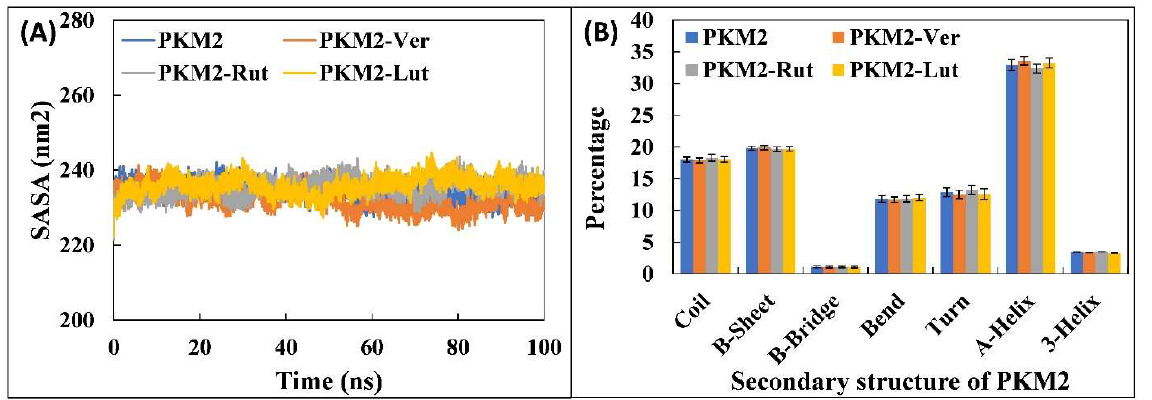
Figure 5. Number of hydrogen bonds formed between PKM2-Ver, PKM2-Rut, and PKM2-Lut complexes over the entire course of simulation.